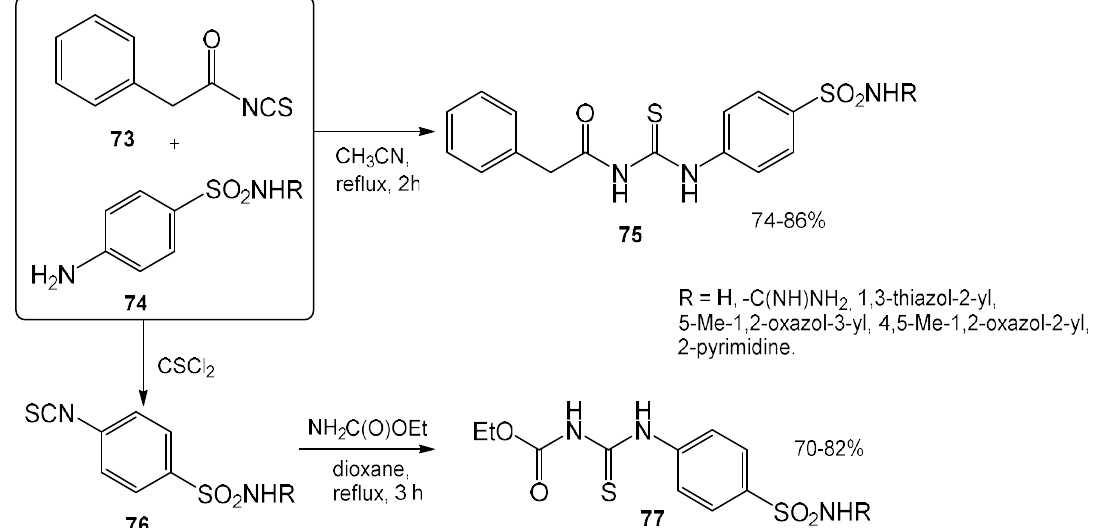
Fig. 21. Strategy of searching for antibacterial agents based on known sulfamide